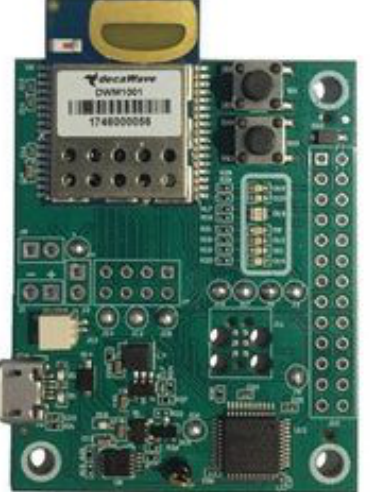
Figure 11. DWM1001